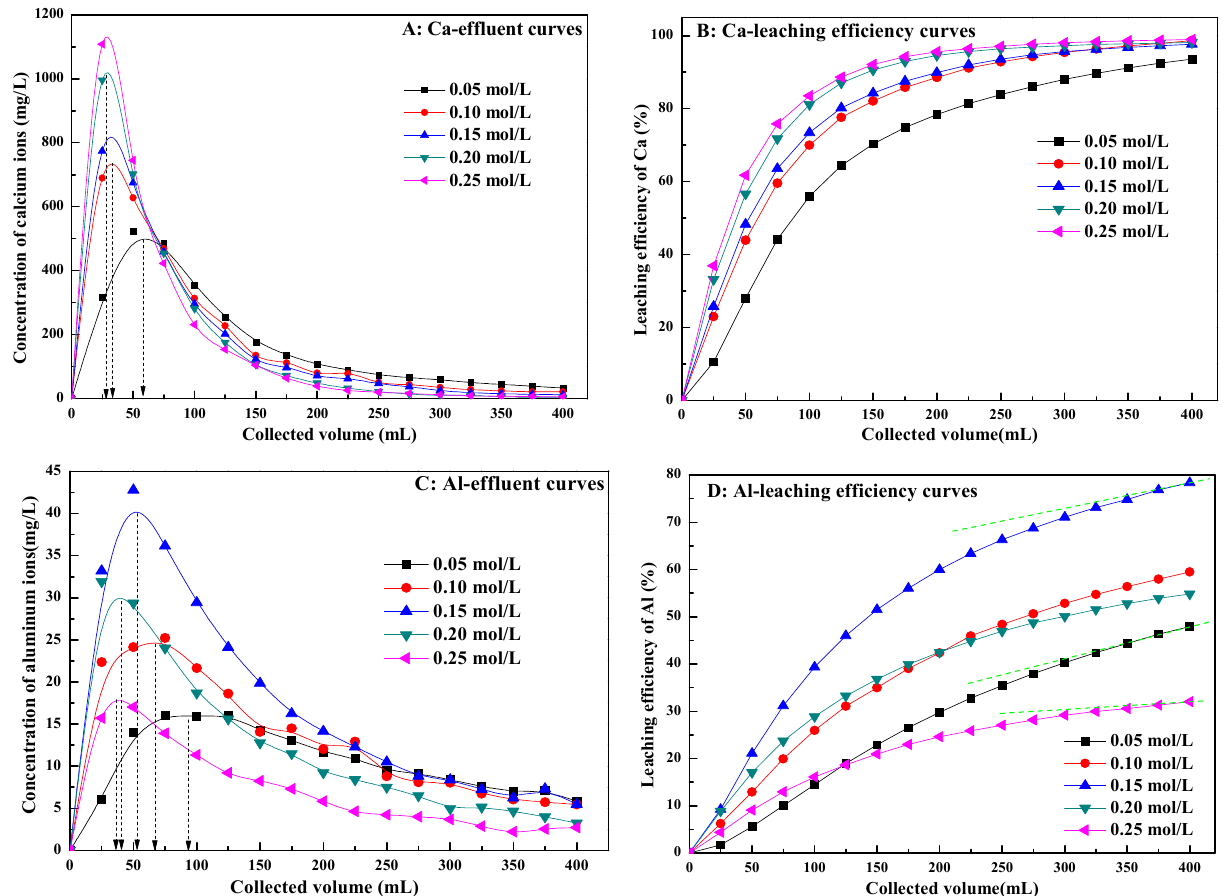
Figure 11. Column leaching behaviors of calcium and aluminum with different MgSO 4 concentrations (T = 20 °C, υ = 0.60 mL/min, pH = 5.70). ( A ) Ca-effluent curves, ( B ) Ca-leaching efficiency curves, ( C ) Al-effluent curves, ( D ) Al-leaching efficiency curves)